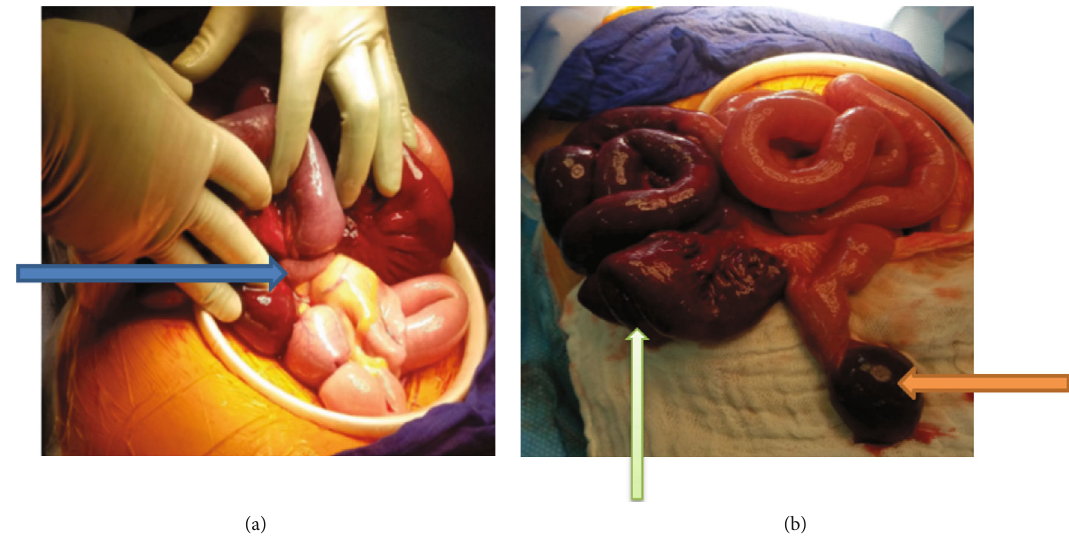
Figure 2: Intraoperative image showing Meckel ’ s diverticulum attached to the mesentery (a, blue arrow), necrotic at its tip (orange arrow), and necrotic intestinal loops (b, green